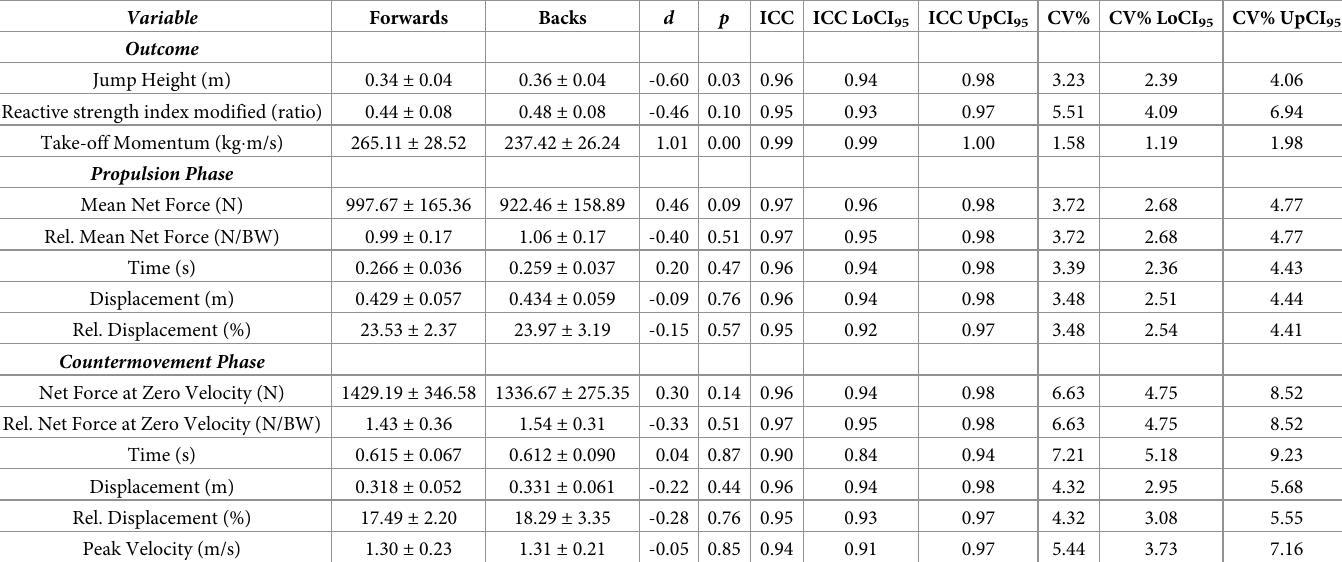
Table 1. The mean ( ± standard deviation) countermovement jump outcome and strategy values attained by each position and associated reliability data. Variable